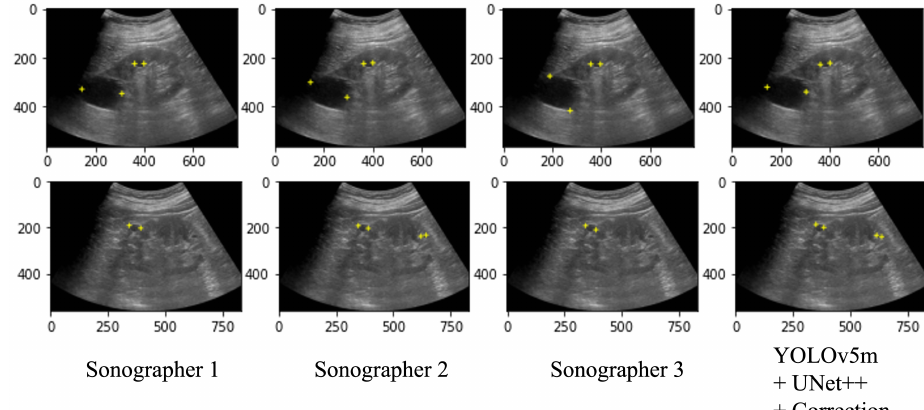
Figure 7. Ultrasound images with salient landmarks placed by sonographers and placed at coordi- nates predicted by the automated system.